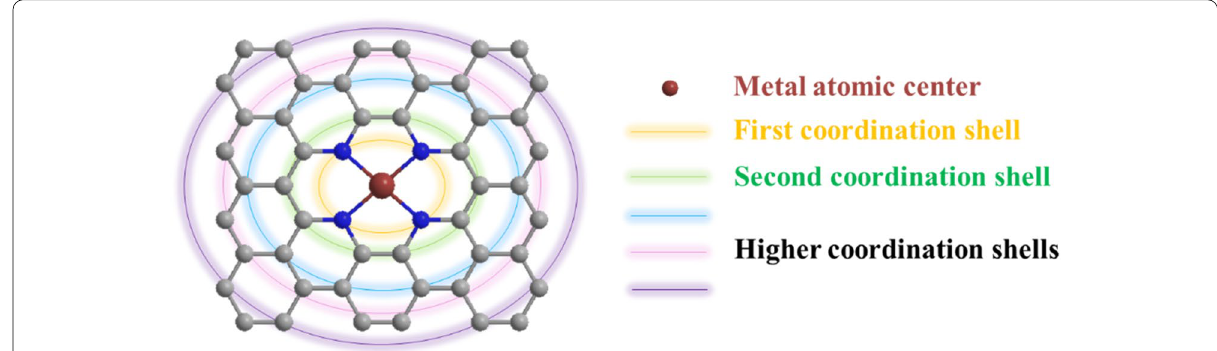
Fig. 1 Schematic illustration of the coordination structure of carbon‑based